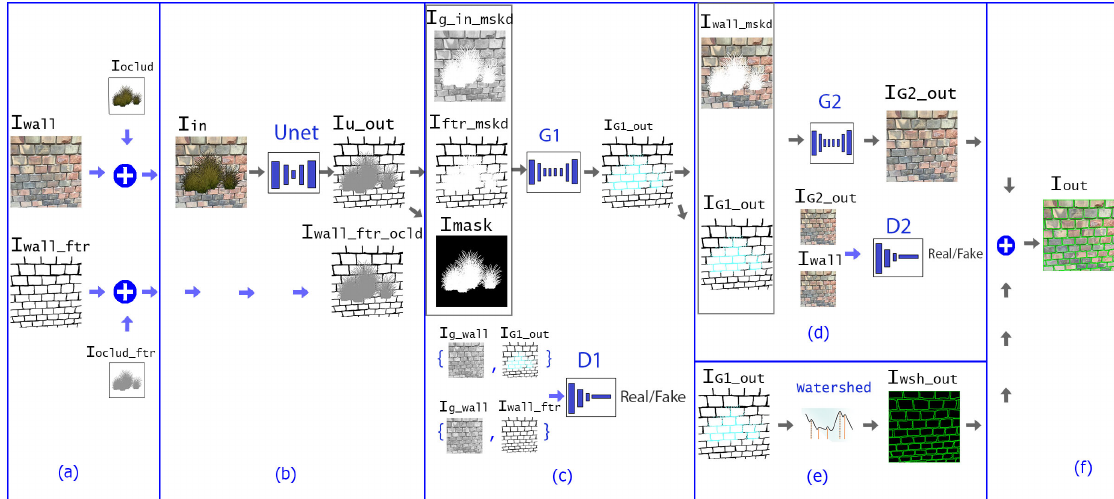
Figure 5. Dataflow of our algorithm. ( a ) Data augmentation by adding synthetic occlusion ( b ) Pre-processing Stage (U-Net network): the input I in contains a wall image with occluding